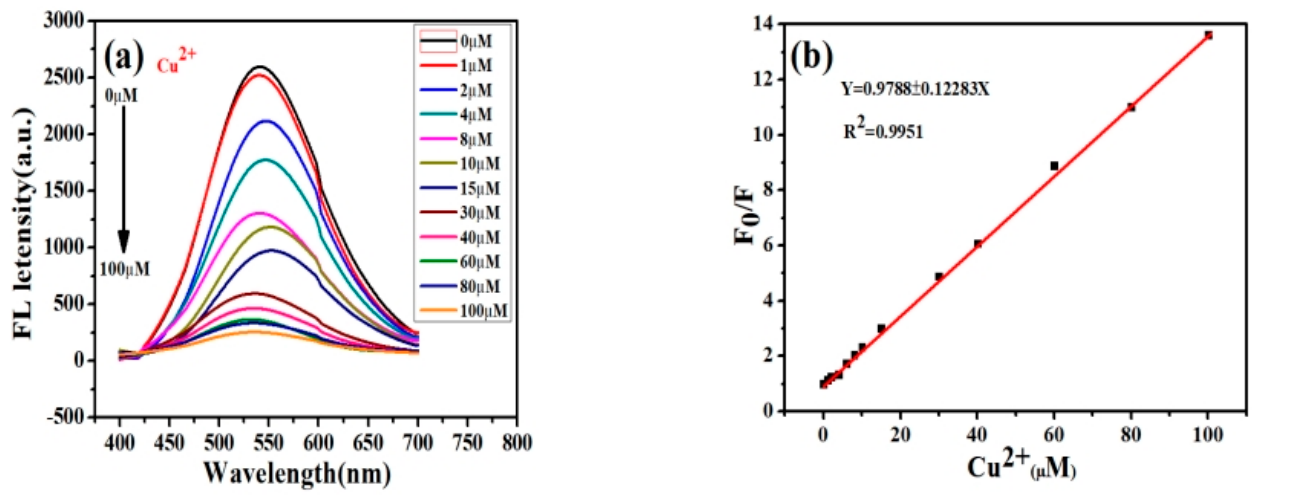
Figure 5. ( a ) Fluorescence spectra of different concentrations of Cu 2+ ; ( b ) fitted curve of the linear relationship.